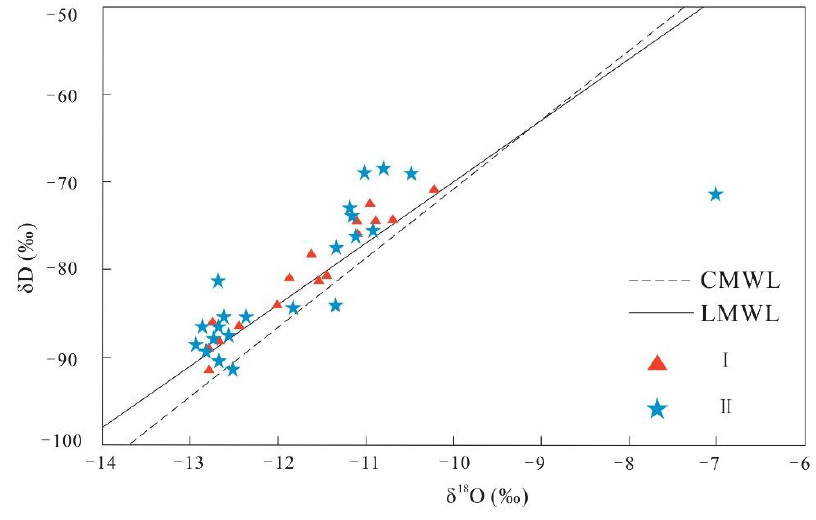
Figure 7. Plot of δ d 18 O and δ D in the water samples. CMWL, China meteoric water line; LMWL, local meteoric water line.